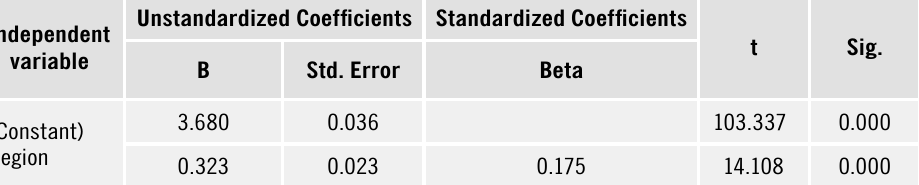
Table 3. Linear regression model illustrating the significance of the region for women’s